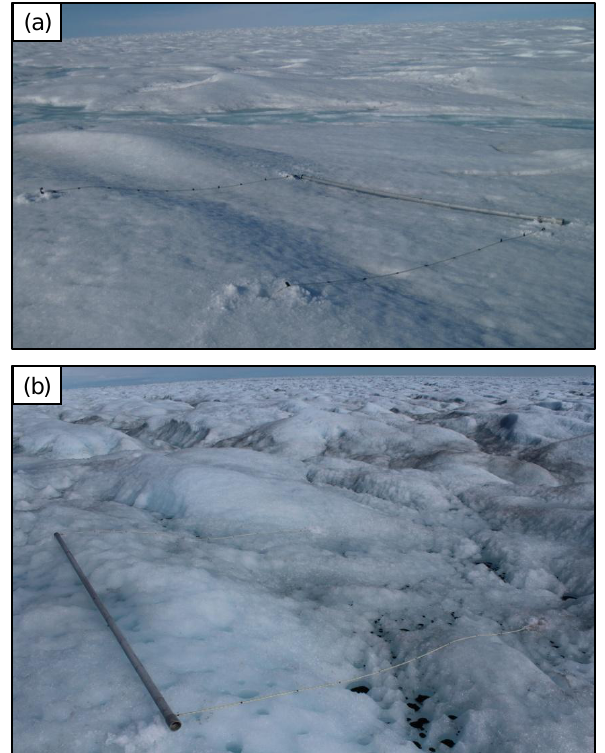
Figure 9. Quadrat Q3 on (a) 1 June 2012, with the pole on Row 12 and (b) 31 July 2012, with the pole on Row 1. The photos were taken looking approximately northeast. Note the darker and rougher surface on 31 July compared with 1 June.